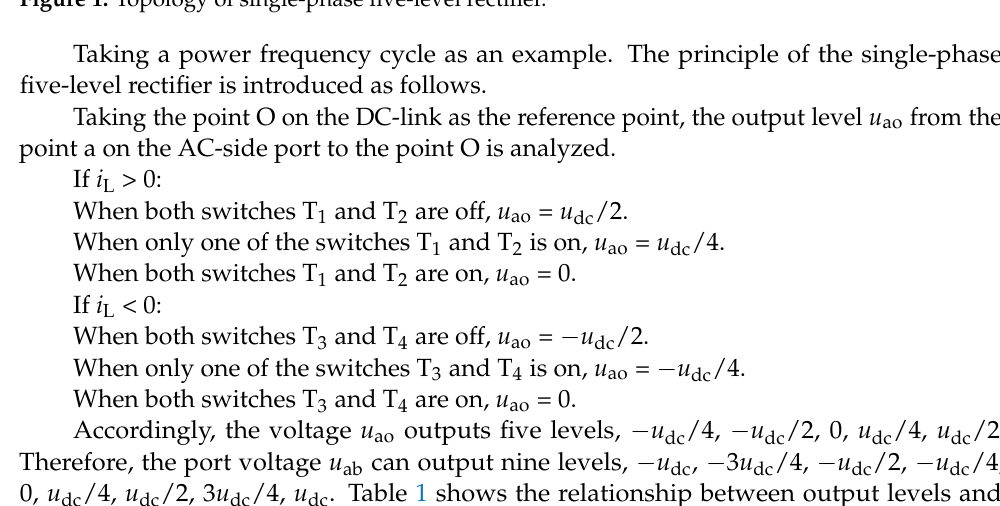
Figure 1. Topology of single - phase five - level rectifier.